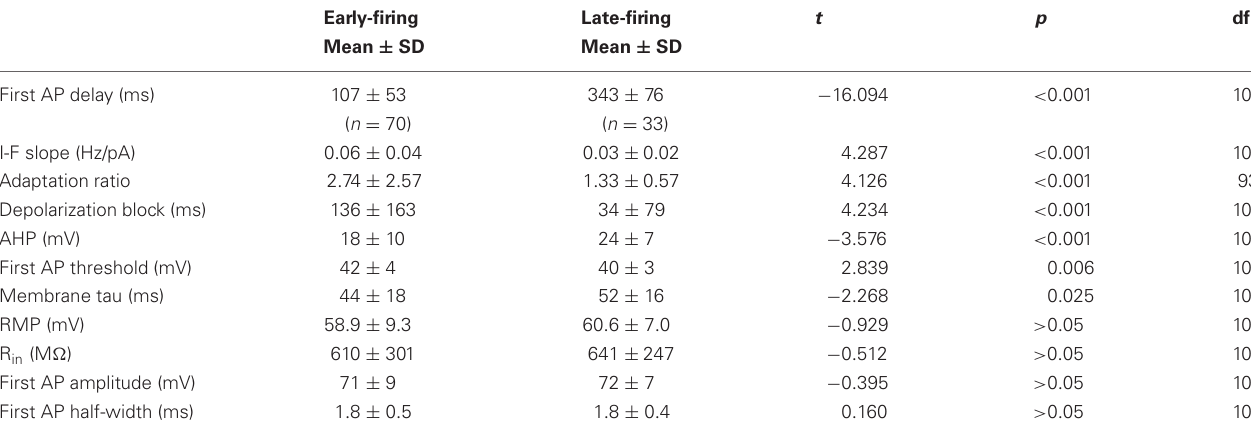
Table 2 | Early- (EF) and Late-firing (LF) cell’s physiological